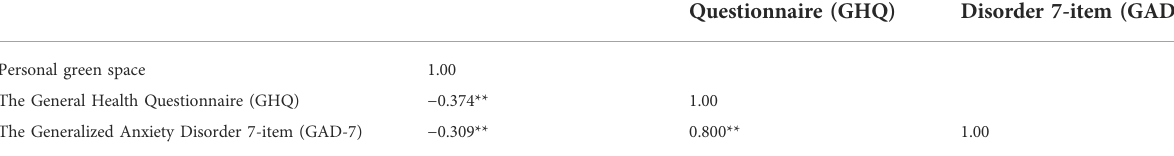
TABLE 5 Correlation of model